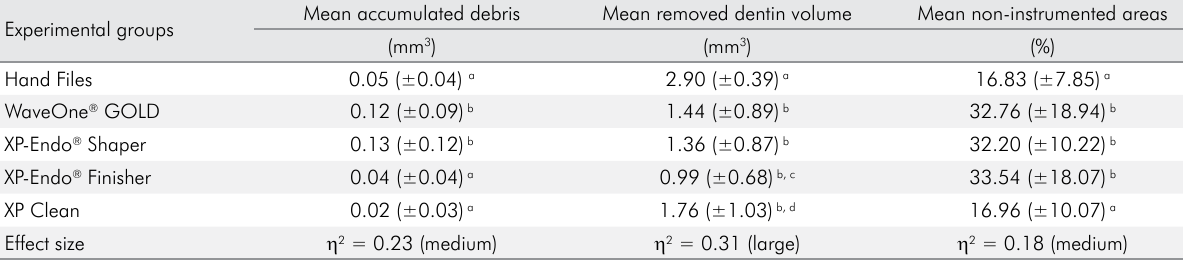
Table 2. Accumulated debris after instrumentation, removed dentin volume, and percentage of non-instrumented areas among the experimental